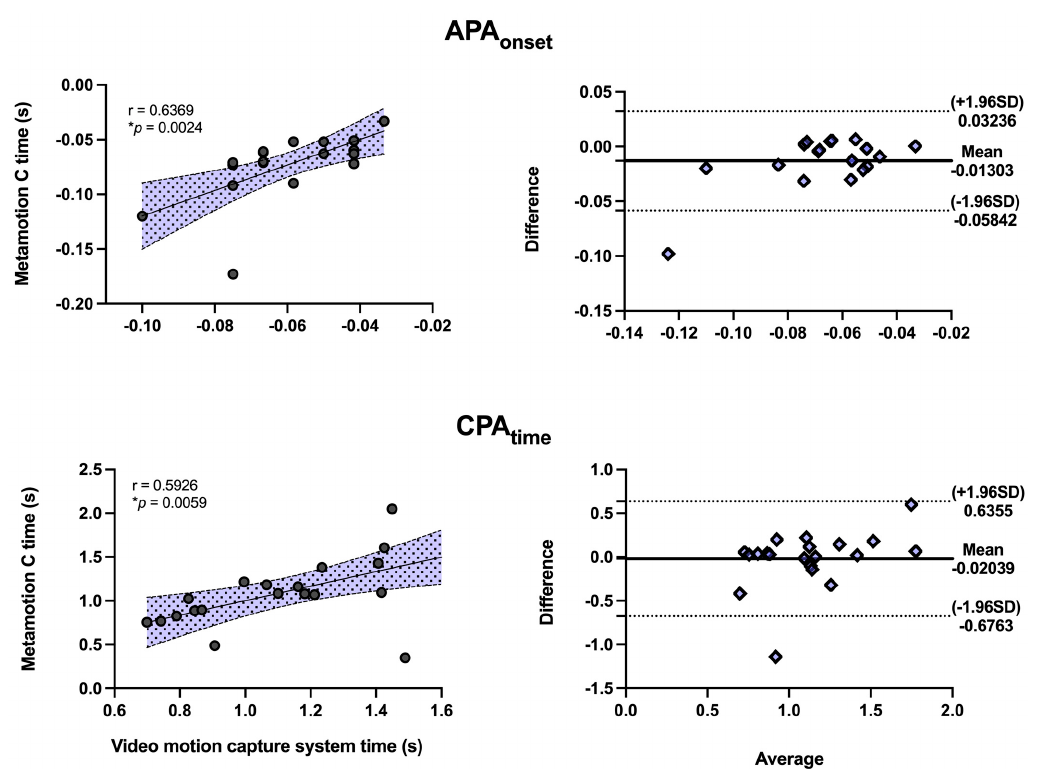
Figure 5. Linear correlation graphs and Bland–Altman correlation graphs show the correlation between evaluation instruments, where r ≥ 0.5 represents a moderate correlation, and the asterisk (*) represents the values that obtained statistical significance ( p ≤ 0.05).